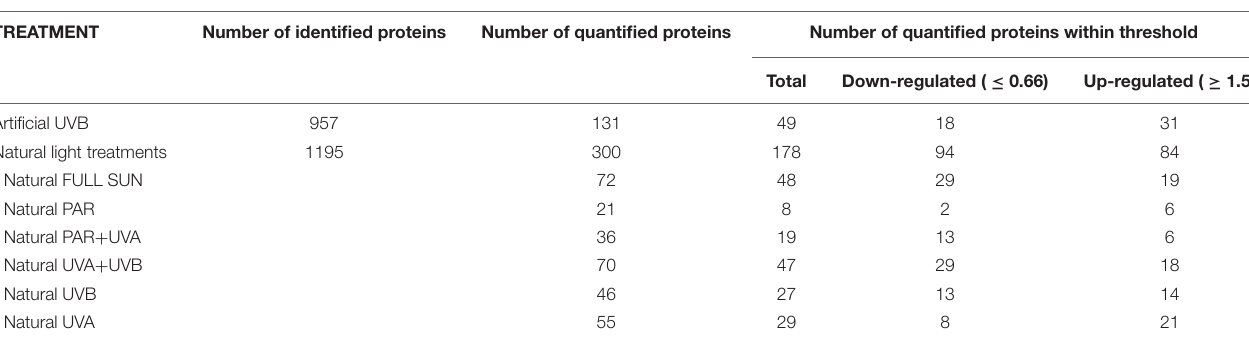
TABLE 2 | Summary of the number of quantified proteins for the different conditions. TREATMENT Number of identified proteins Number of quantified